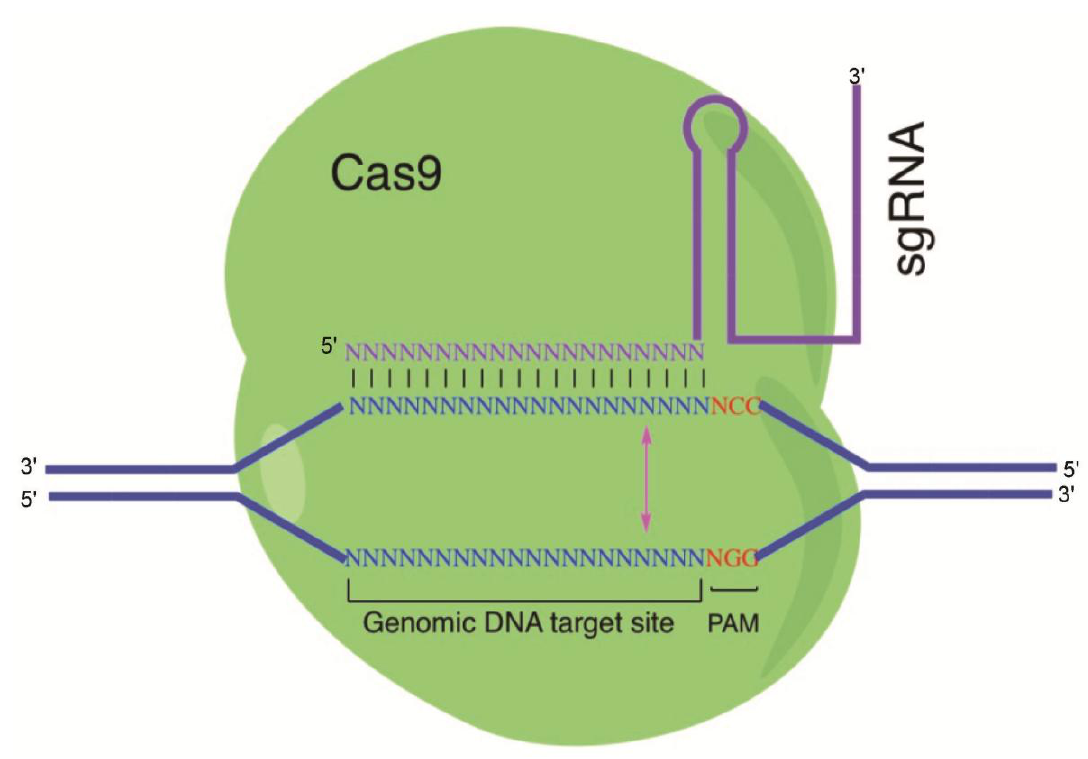
Figure 1. Illustration of the CRISPR/Cas9 system: The Cas9 protein interacts with the single-guide RNA (sgRNA) to direct endonuclease activity proximal to the protospacer adjacent motif (PAM) sequence. Custom-designed sgRNAs recognize their target sequence and allow Cas9 endonuclease to cleave the sense strand 3 base pairs (bp) and antisense strand 3 bp upstream of the PAM sequence (NGG). Binding of sgRNAs to the target sites induces Cas9 endonuclease to create a double-strand break (blunt end) on the genomic target.